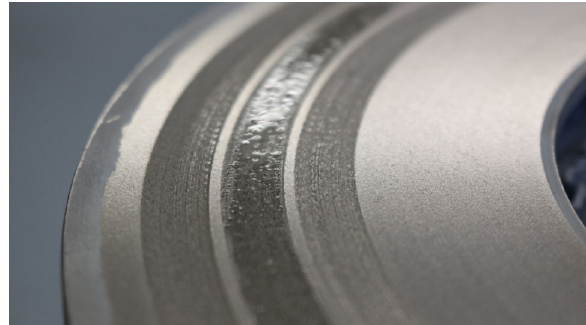
Fig. 4 Fluid film in the middle friction track at approximately 2 × 10 − 4 kg glycerol.